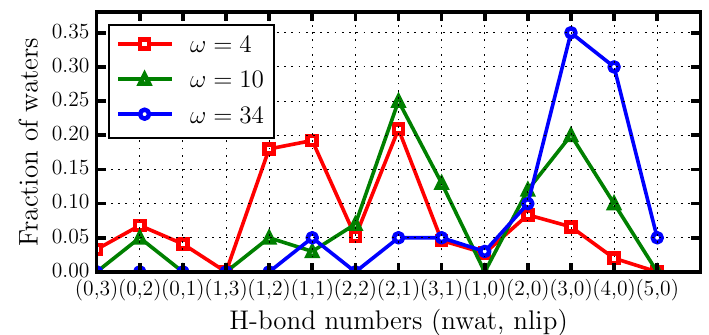
Figure 6. Fraction of water molecules forming n wat HBs with other water molecules, and, at the same time, n lip HBs with lipids, indicated along the x -axis as ( n wat , n lip ) , for different hydration levels. At high hydration ( ω = 34, blue circles) the HBs are mainly among water molecules. At medium hydration ( ω = 10, green triangles) the most likely structures have n wat = 2 and n lip = 1, but still many water molecules have no HBs with lipids. At low hydration ( ω = 4, red squares), in general, the water HBs are involving at least one lipid and one or two more water